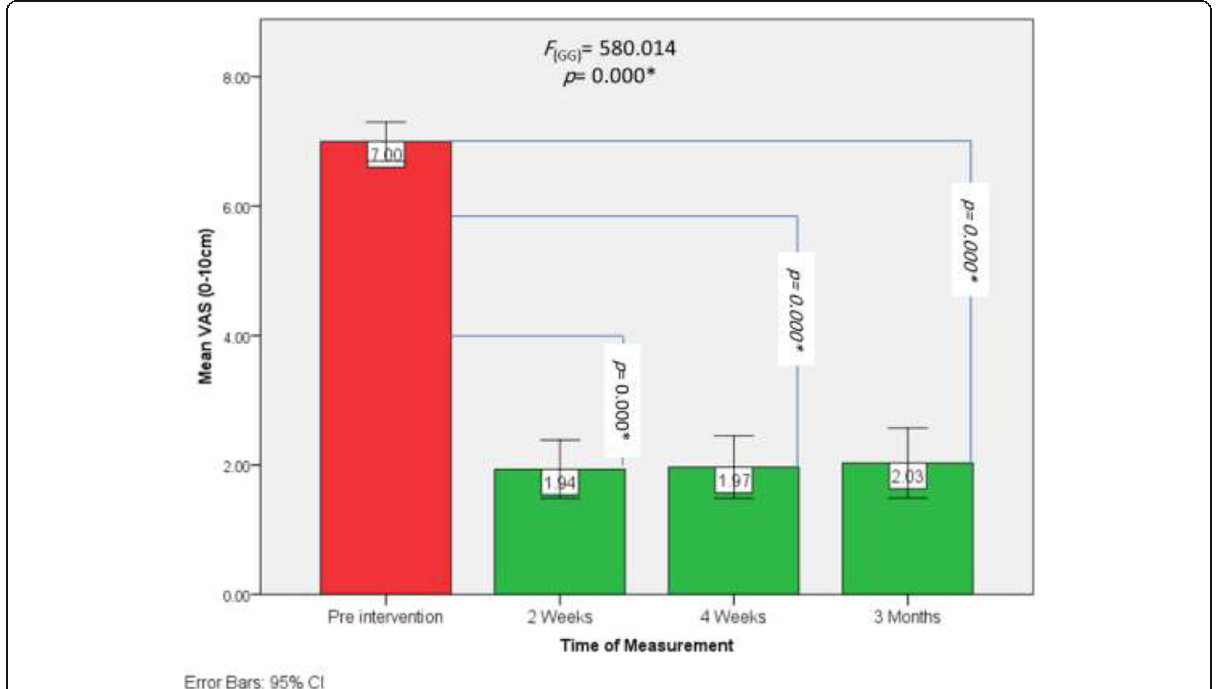
Fig. 12 Bar chart with 95% CI error bar, comparison between the pre- and post-intervention mean visual analogue scale (VAS) level